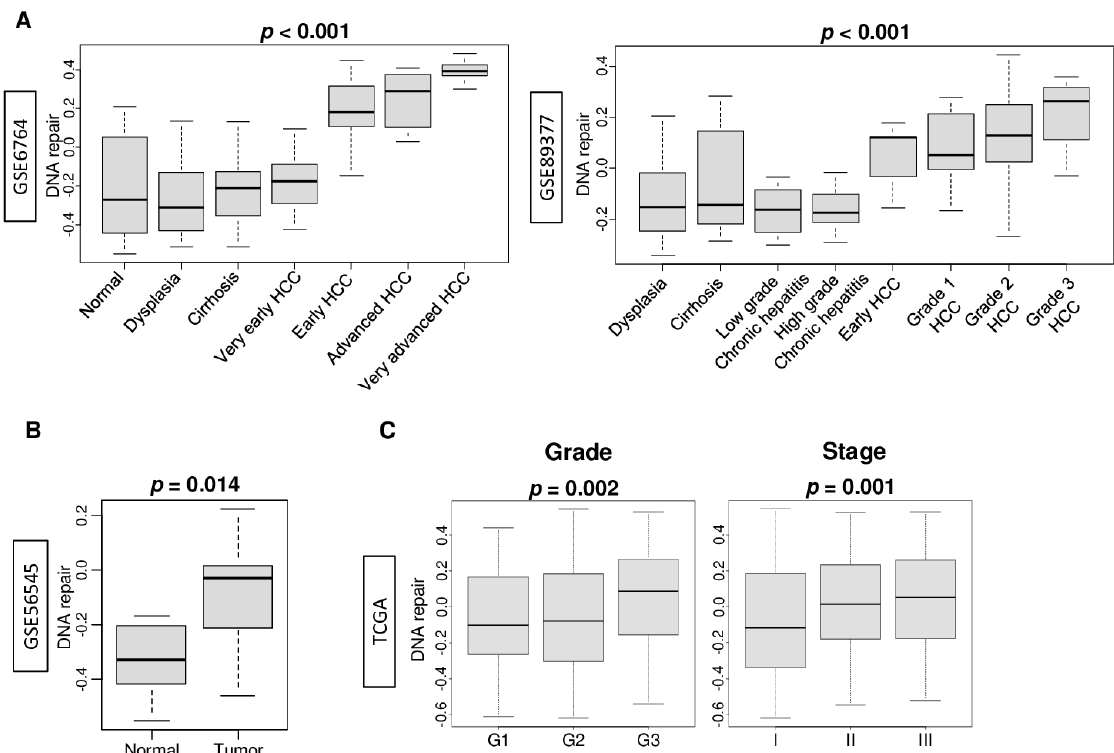
Figure 1. Association between DNA repair and hepatocarcinogenesis. ( A ) Boxplots of the comparison of the DNA repair score by multistep hepatocarcinogenesis, including normal liver tissue ( n = 8), dysplasia ( n = 17), cirrhosis ( n = 13), very early hepatocellular carcinoma (HCC) ( n = 8), early HCC ( n = 10), advanced HCC ( n = 7), and very advanced HCC ( n = 10) defined by the GSE6764 ( n = 75) cohort; and dysplasia ( n = 35), cirrhosis ( n = 12), low-grade ( n = 8) and high-grade ( n = 12) chronic hepatitis, early HCC ( n = 5), and grades 1–3 ( n = 9, 12, and 14, respectively) of HCC defined by the GSE98377 ( n = 107) cohort. ( B ) Boxplots of the comparison of the DNA repair score between normal tissue ( n = 12) and primary tumor ( n = 12) in the GSE56545 ( n = 42) cohort. ( C ) Boxplots of the comparison of the DNA repair score by pathological grade G1–3 ( n = 53, 168, and 121, respectively) and American Joint Committee on Cancer (AJCC) stage I–III ( n = 166, 81, and 84, respectively) in the TCGA cohort. The p -value was calculated using a Kruskal–Wallis test or Mann–Whitney U test.